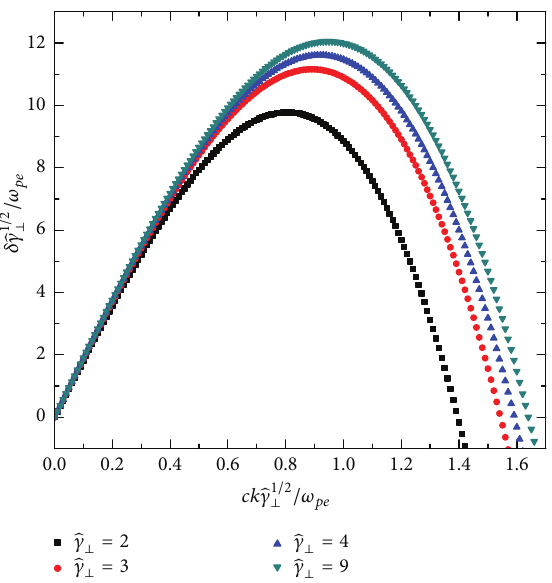
Figure 5: Variation of the normalized growth rate, (𝛿/𝜔 𝑝𝑒 )̂𝛾 1/2 ⊥ , according to (𝑐𝑘/𝜔 𝑝𝑒 )̂𝛾 1/2 ⊥ for difference ̂𝛾 ⊥ in limits 𝜂 = 0.909 and 𝛼 = 0.3